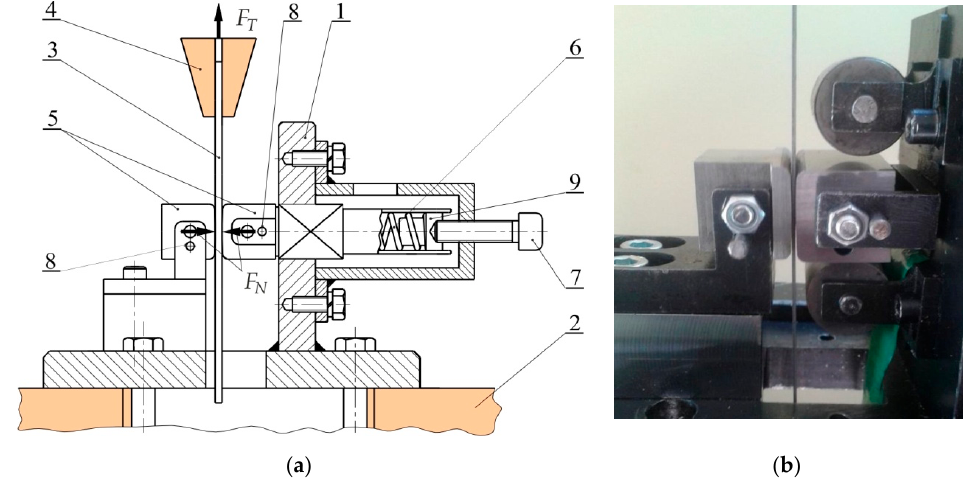
Figure 2. ( a ) layout and view of the device and ( b ) view of the working zone: 1—frame, 2—bottom grip of testing machine, 3—specimen, 4—upper grip of testing machine, 5—countersamples, 6—spring, 7—bolt; 8—fixing pins, 9—teflon washer. Table 4. Selected surface roughness parameters of countersample with radius R = 200 mm.